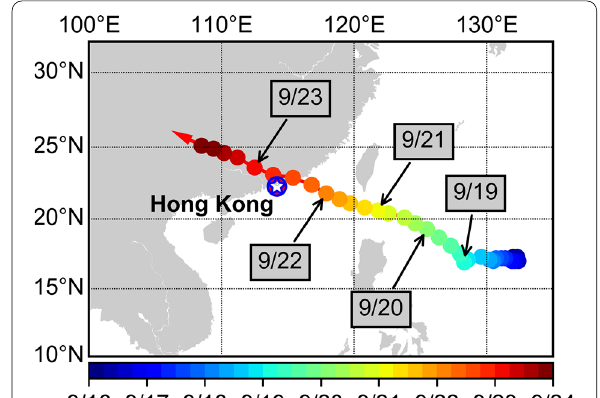
Fig. 1 Trajectory of the tropical cyclone Usagi 2013. It was generated on 16 September 2013 and dissipated on 24 September 2013. The dots with colors denote the locations of the tropical cyclone center at the corresponding time. The circle with a star represents the location of Hong